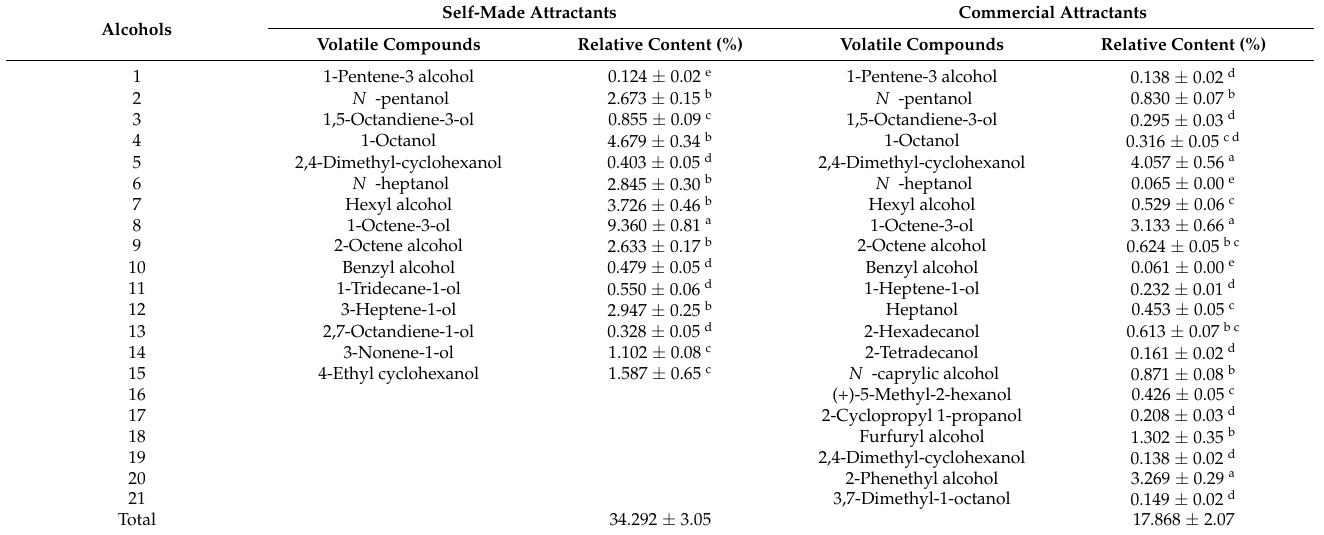
Table 3. Alcohols in self-made and commercial attractants (percentage of the total peak